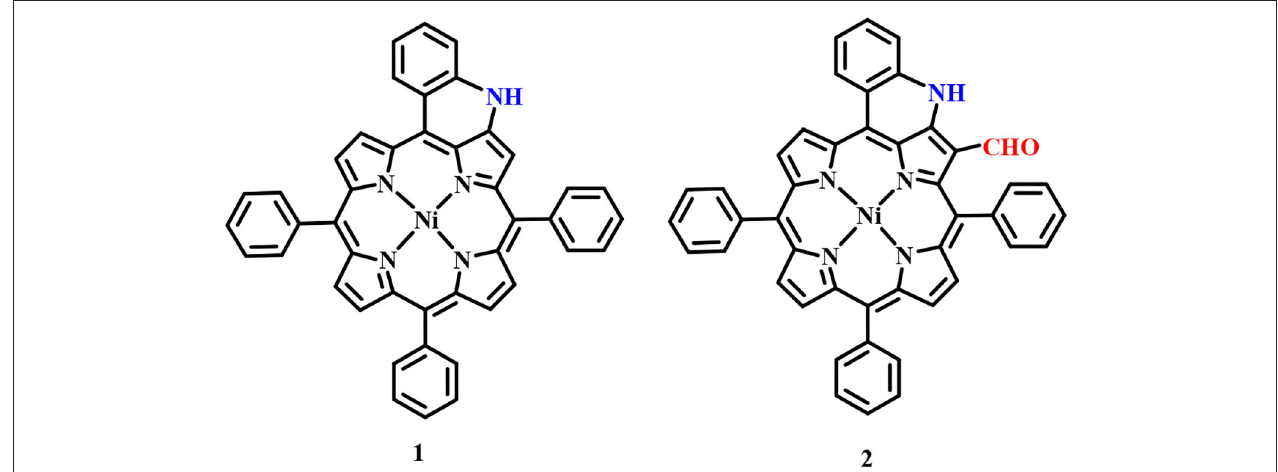
FIGURE 1 | Chemical structures of sensors 1 and 2 used for detecting anions and cations,